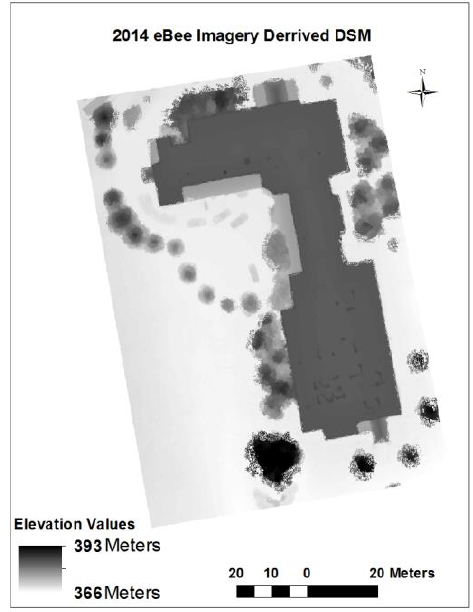
Figure 2. eBee Imagery Derived